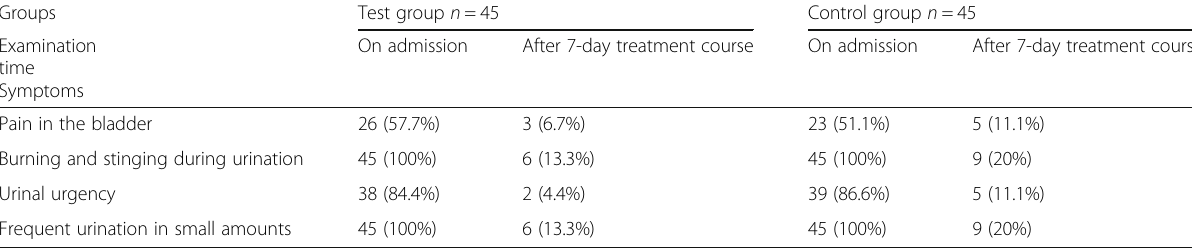
Table 2 Cystitis symptoms in the two treatment groups, on admission and after 7-day treatment Groups